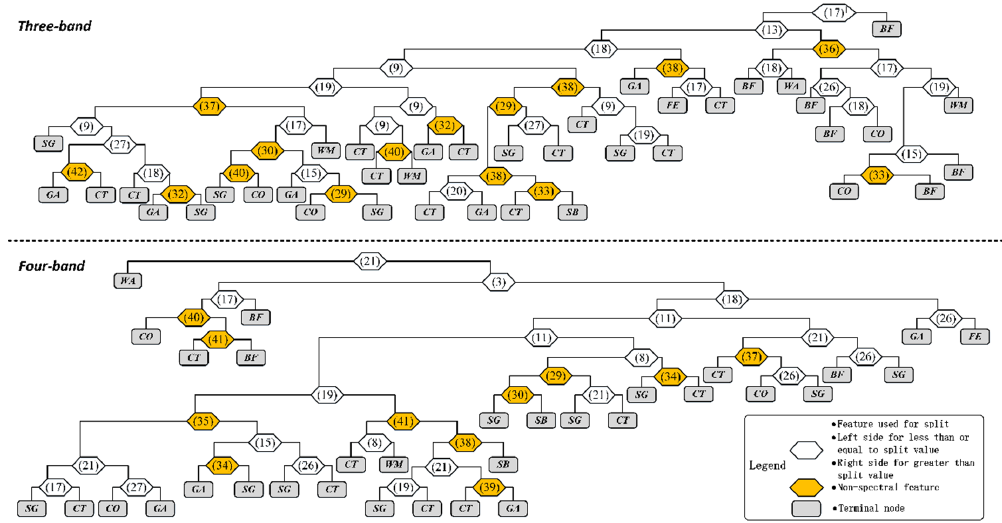
Figure 8. Decision tree models for object-based classification. Abbreviations for the 10 classes: IM=impervious, BF=bare soil and fallow, GA=grass, FE=forest, WA=water, SB=soybean, WM=watermelon, CO=corn, SG=sorghum, and CT=cotton. 1 (n) is the number ID of each feature, ranging from (1) to (42), which is described in Table 2.